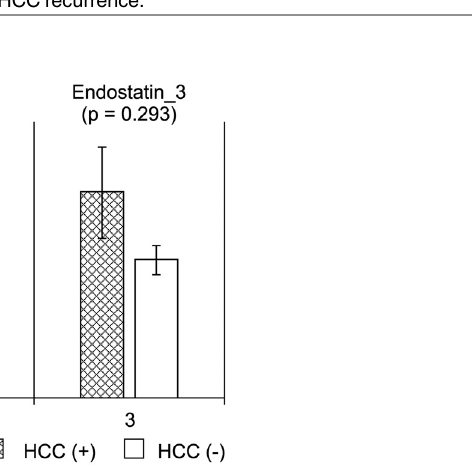
Fig 4. Statistical analysis of FGF-2, survivin, Ki67, endostatin, and VEGF levels, as measured by ELISA before (_1), early after (_2), and late after (_3) after living donor liver transplantation (LDLT). The Mann-Whitney U test was used to compare the differences in the biomarkers at the various time points between the recipients with and those without HCC